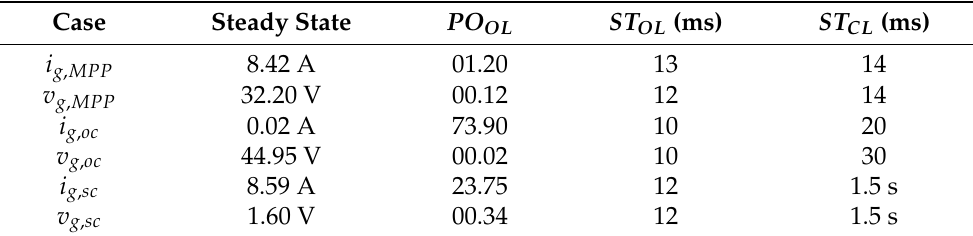
Table 1. Comparison of closed and open loop response of PV